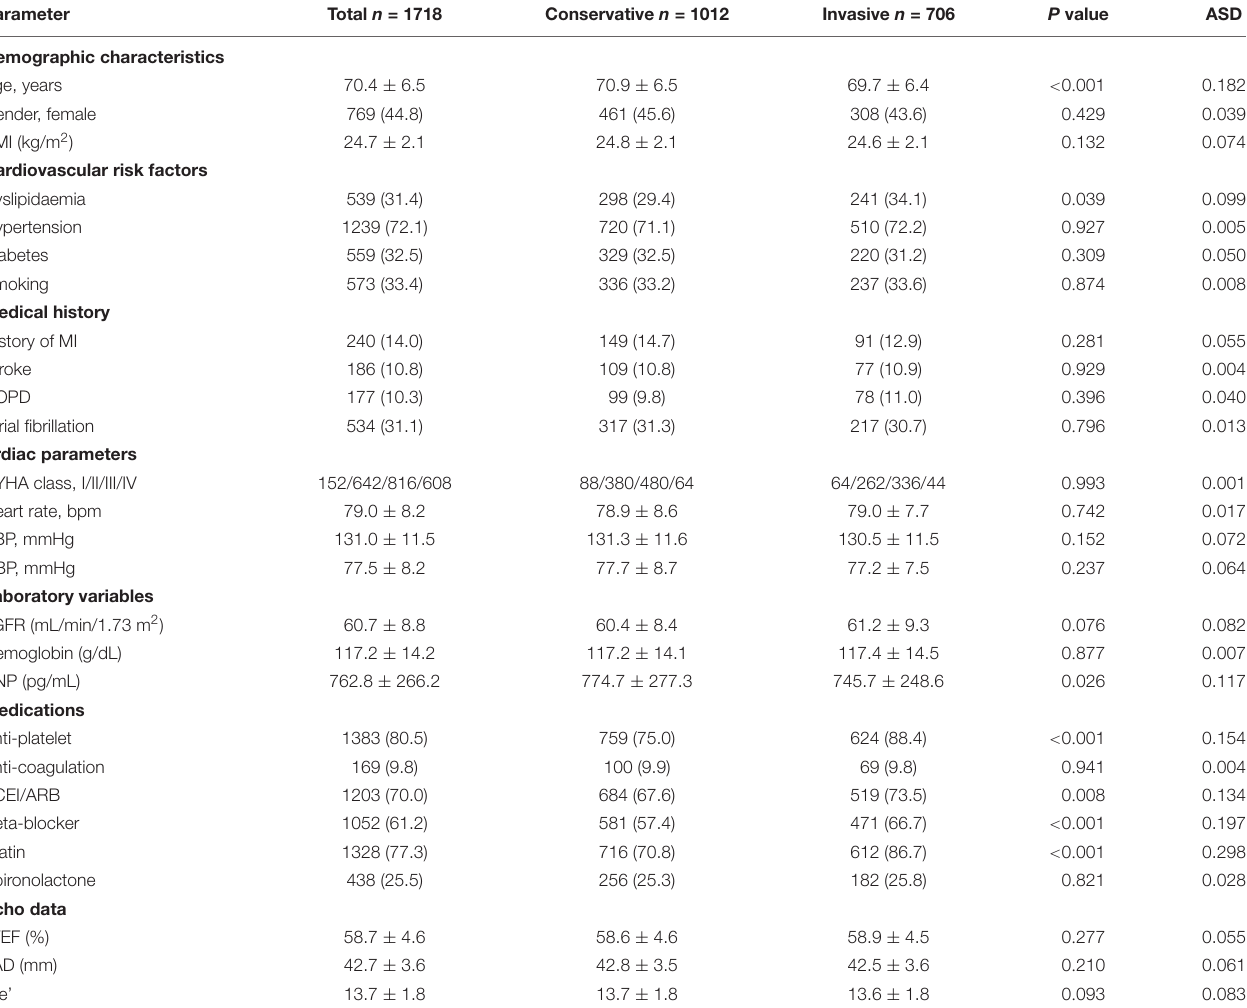
TABLE 1 | Baseline clinical characteristics and medications.